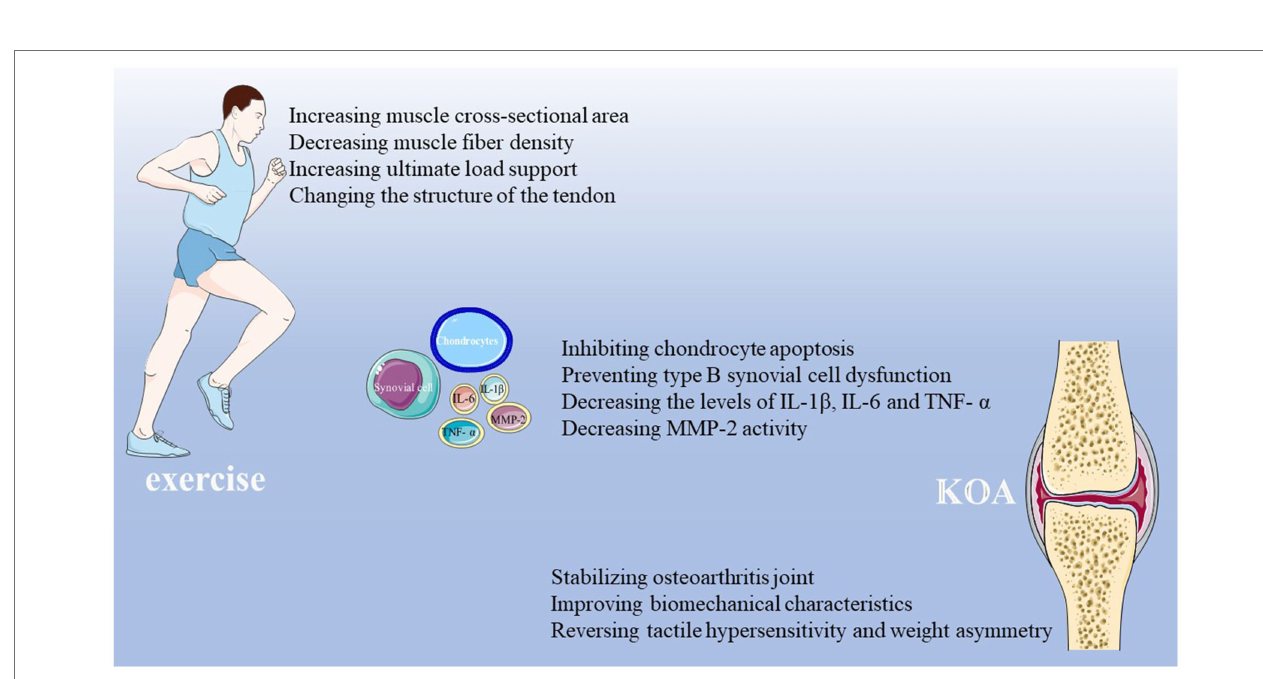
FIGURE 2 | The main symptoms of patients with KOA. The main symptoms of patients with KOA include pain, stiffness, muscle weakness, and reduced joint mobility. Pain is always associated with inflammatory stimulation, and never conduction. Joint fibrosis and joint adhesion are related to stiffness. Muscle dysfunction can cause muscle weakness. Joint space narrowing is related to reduced joint